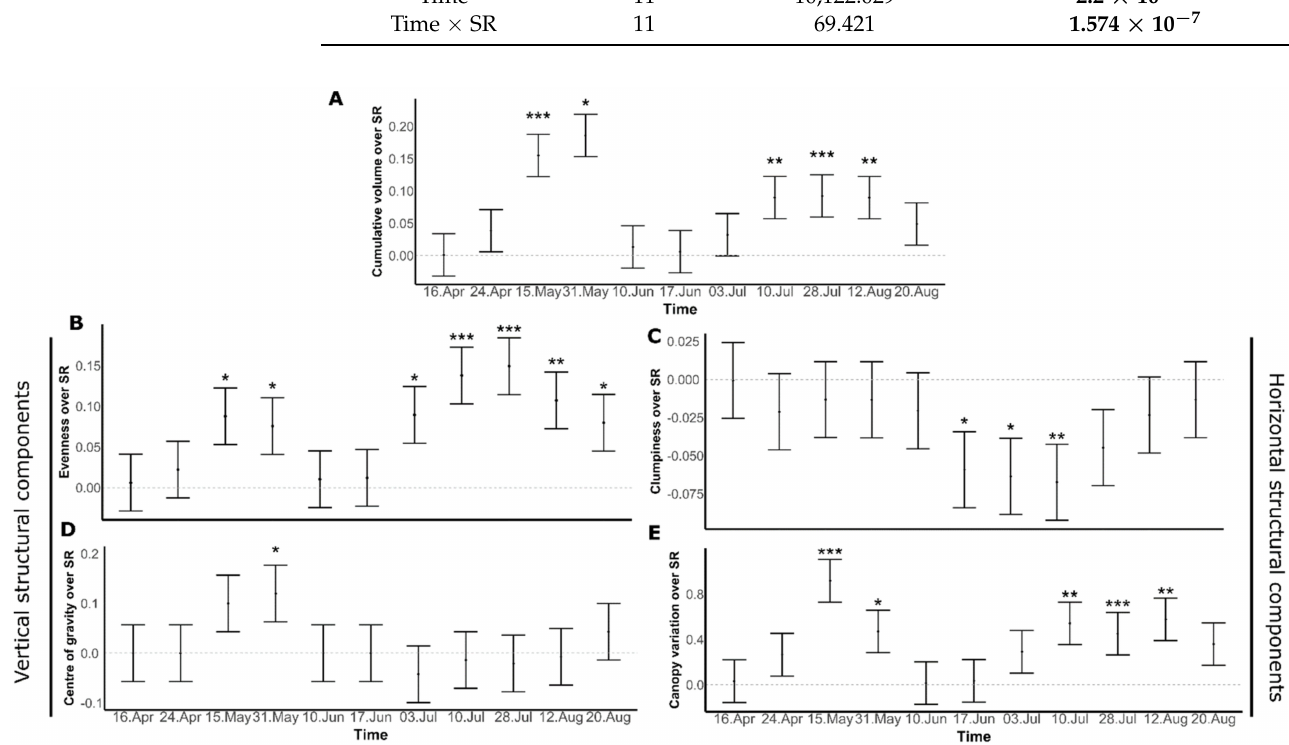
Figure 3. Coefficient plot showing the variation of estimates (effect sizes) of species richness (SR), its contrast to zero with 95% confidence intervals. ( A ) shows the slope each of the cumulative volume and ( B ) for evenness, ( C ) for Clumpiness, ( D ) for center of gravity , and ( E ) for canopy variation. The slopes are based on mixed-effects models during the growing season in 2014 with codes for significant relationships: 0 ‘***’ 0.001 ‘**’ 0.01 ‘*’ 0.05